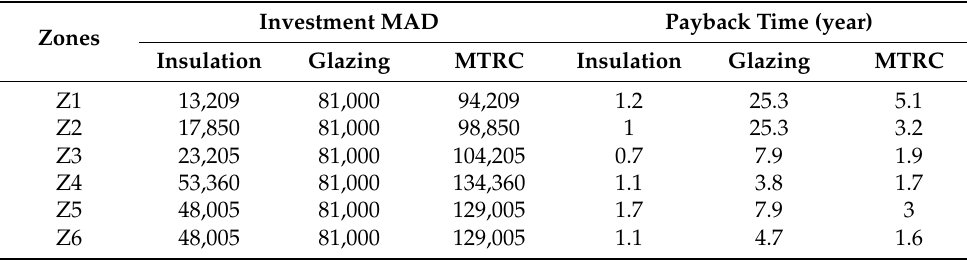
Table 22. Payback time of passive